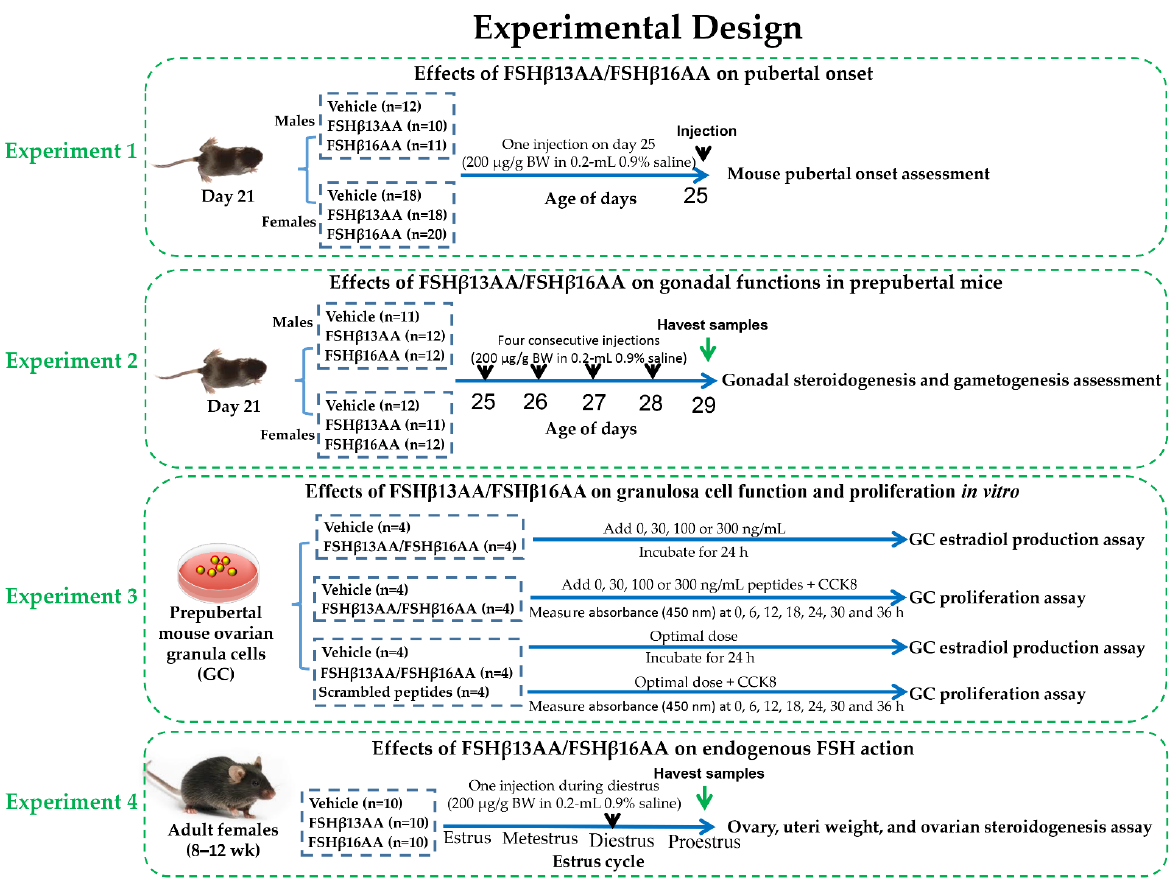
Figure 10. The whole experimental design flow chart.